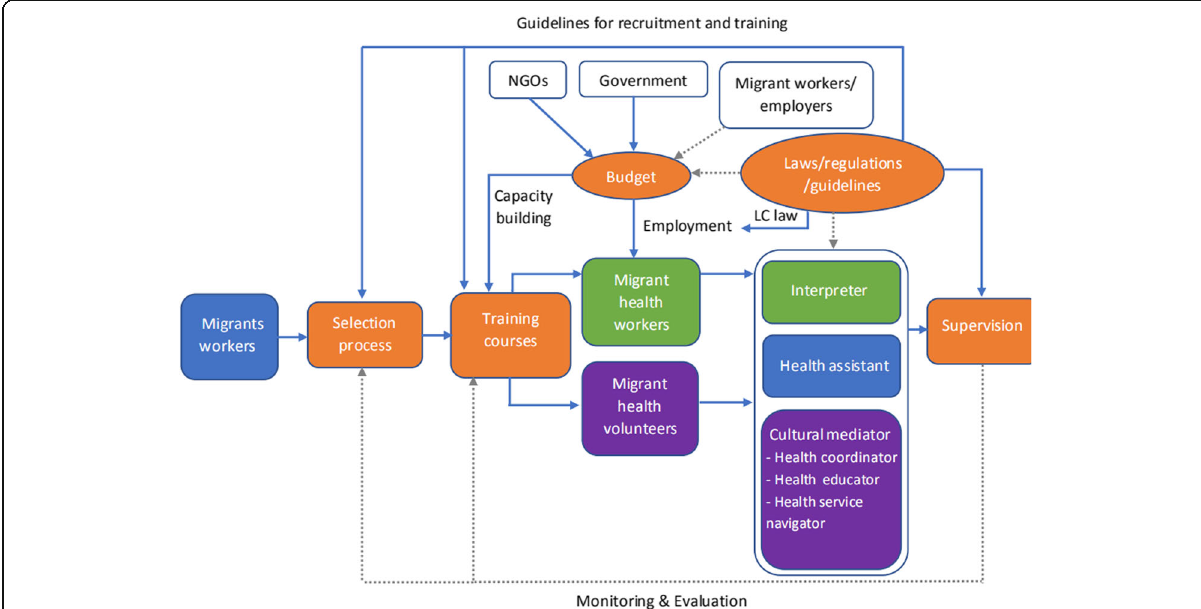
Fig. 1 System support for healthcare interpretation services for migrant workers in Thailand. Note: Blue lines refer to flow of work in MHW and MHV programmes; grey line refers to the ideal system